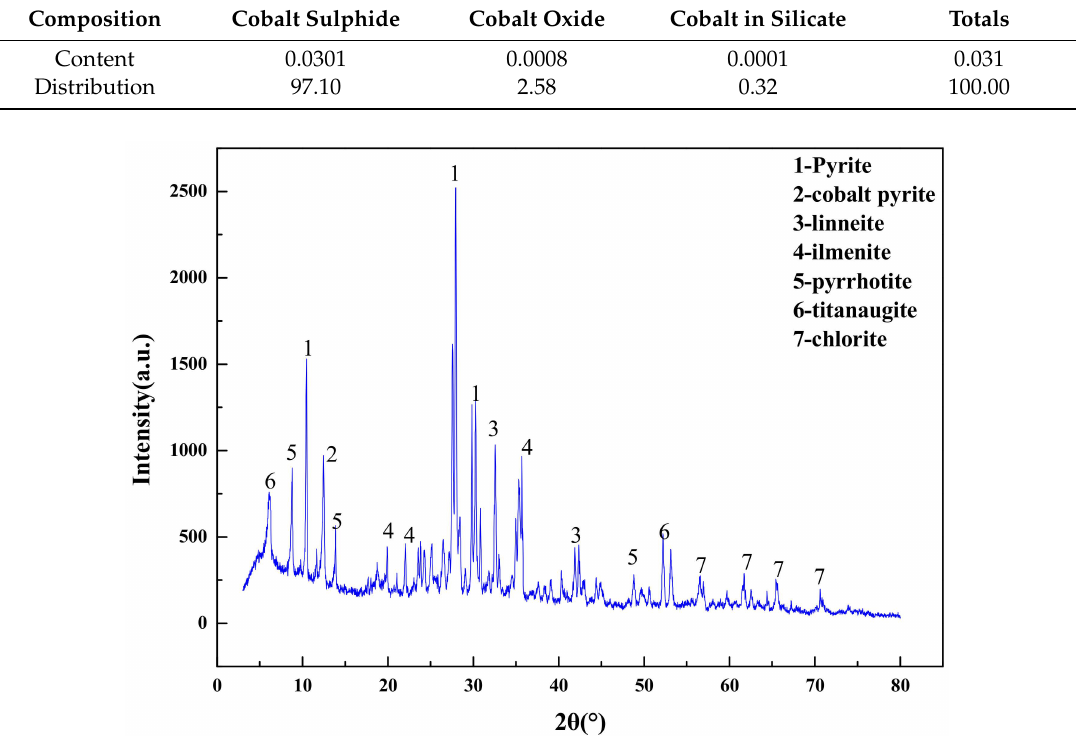
Figure 1. XRD analysis of cobalt-bearing V–Ti magnetite